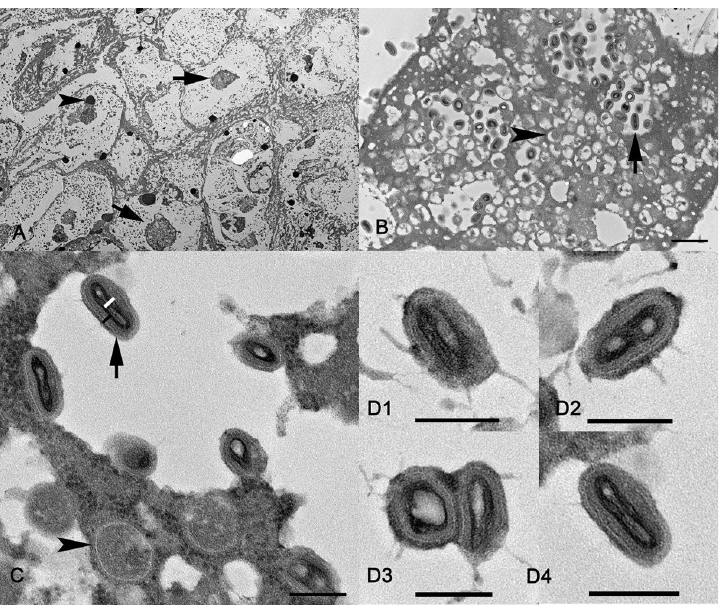
Fig 6. A-D. Ultrastructure of an affected haired skin from huemul limb (Case #10, Table 1). Uranyl acetate/lead citrate contrast. A. The cytoplasm of the stratum granulosum cells is clear and distended by myriad poxvirus particles. Within the cytoplasm, some of these cells presented a large electron-dense aggregation consistent with a viral factory (arrows) and fragment of chromatin (arrowhead). B. Viral factories were characterized by large aggregation of electron-dense amorphous material admixed with immature (arrowhead), maturing and mature virions (arrow). Bar = 600 nm. C. A magnification showed detail of immature virions (arrowhead), which displayed a round shape lined by a radiated membrane. A black bar corresponds to the thickness of the multilayered membrane and a white bar indicates the thickness of the core of a mature virion (arrow). Bar = 200 nm. D. Different axis of mature virions. Note that the core is a folded cylinder with horizontal (D1) cross (D2 and D3), and sagittal (D4) sections. Bar = 200